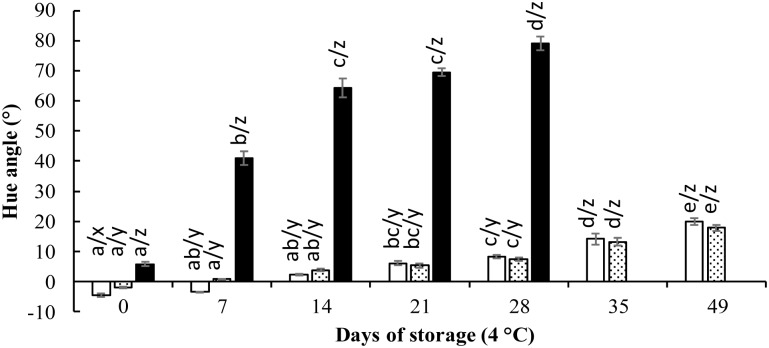
Evolution of hue angle (°) in DEs during storage at 4 °C.DE-CP (white bar), DE-CP-G (dotted bar), DE-CP-GT (black bar). Different letters (x-z) indicate significant differences (p≤0.05) among samples at the same day of storage. Different letters (a-e) indicate significant differences (p≤0.05) throughout the storage time for the same sample.